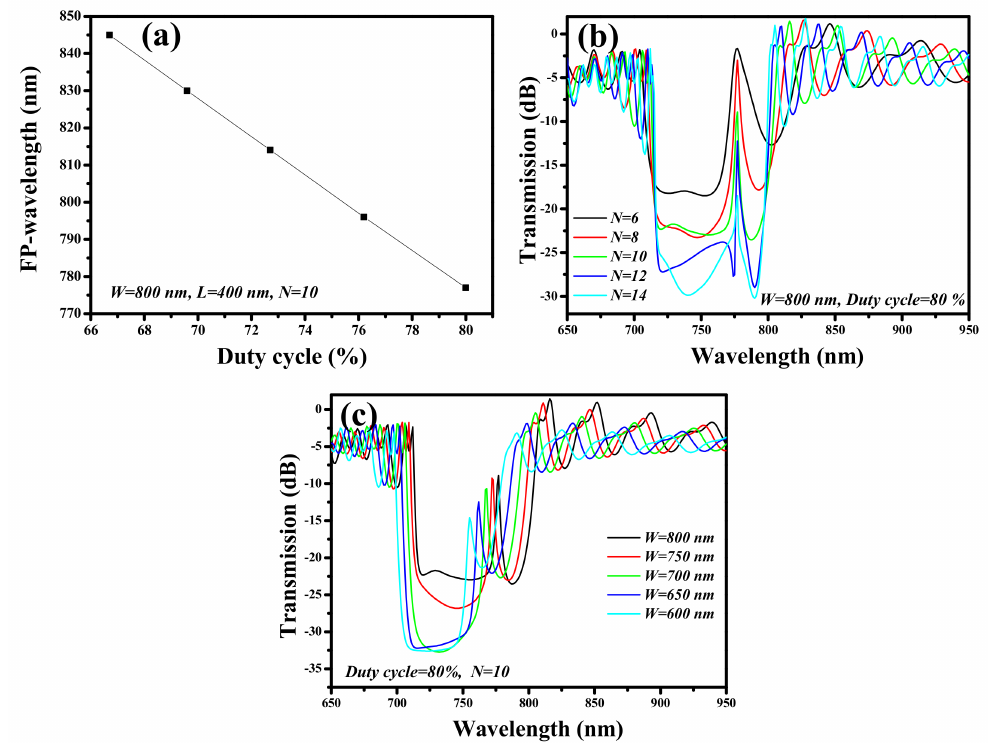
Figure 14. Spectral characteristics of the SWG waveguide-FP structure, ( a ) FP-wavelength versus DC , ( b ) transmission spectrum versus N , ( c ) transmission spectrum versus W